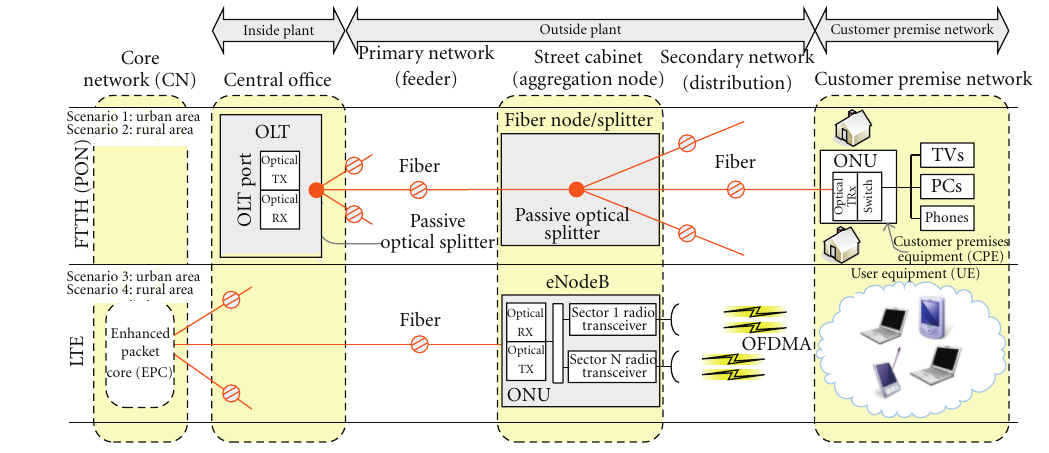
Figure 4: Broadband access network architecture. Table 7: LTE architecture components.